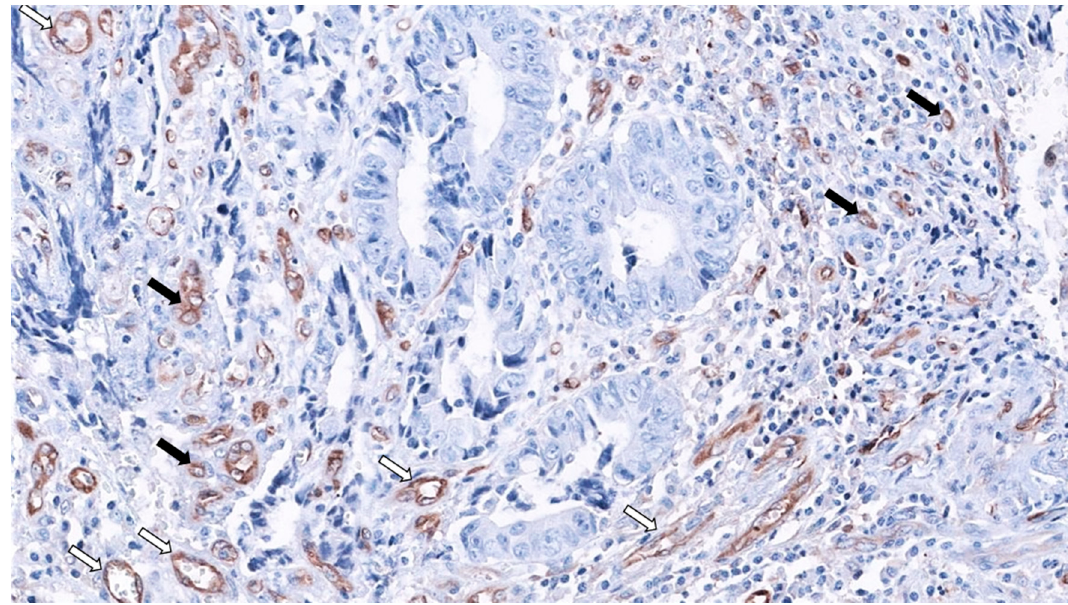
Figure 3. Fascin1 expression in SAC-staining tumor-budding cells (black arrows) and abundant surrounding microvessels (white arrows) 20× original magnification. (Source: Authors).